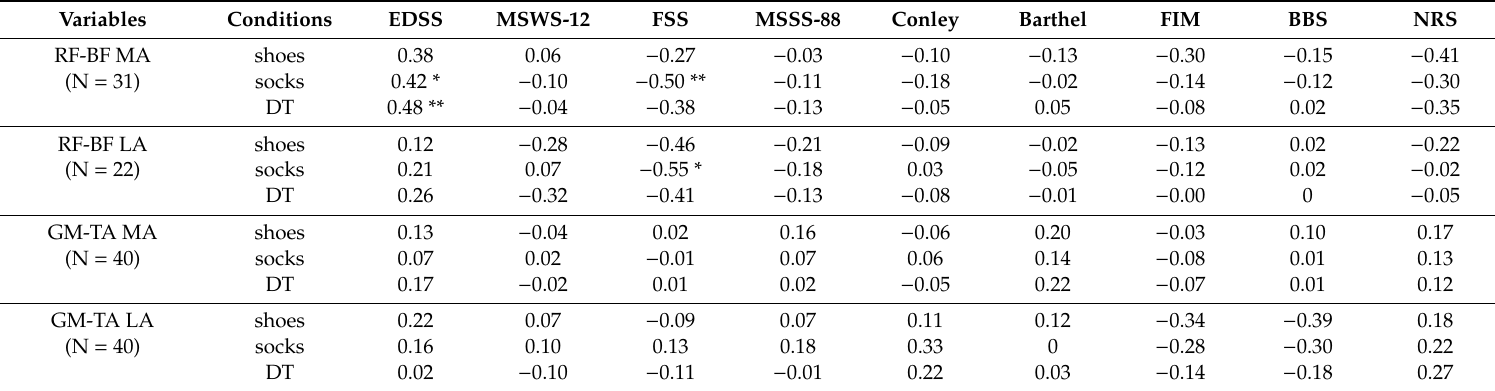
Table 3. Spearman’s correlation coe ffi cient between the coactivation index and clinical assessments in all the conditions. Spearman’s correlation was performed to explore the relationship between sEMG recording and clinical